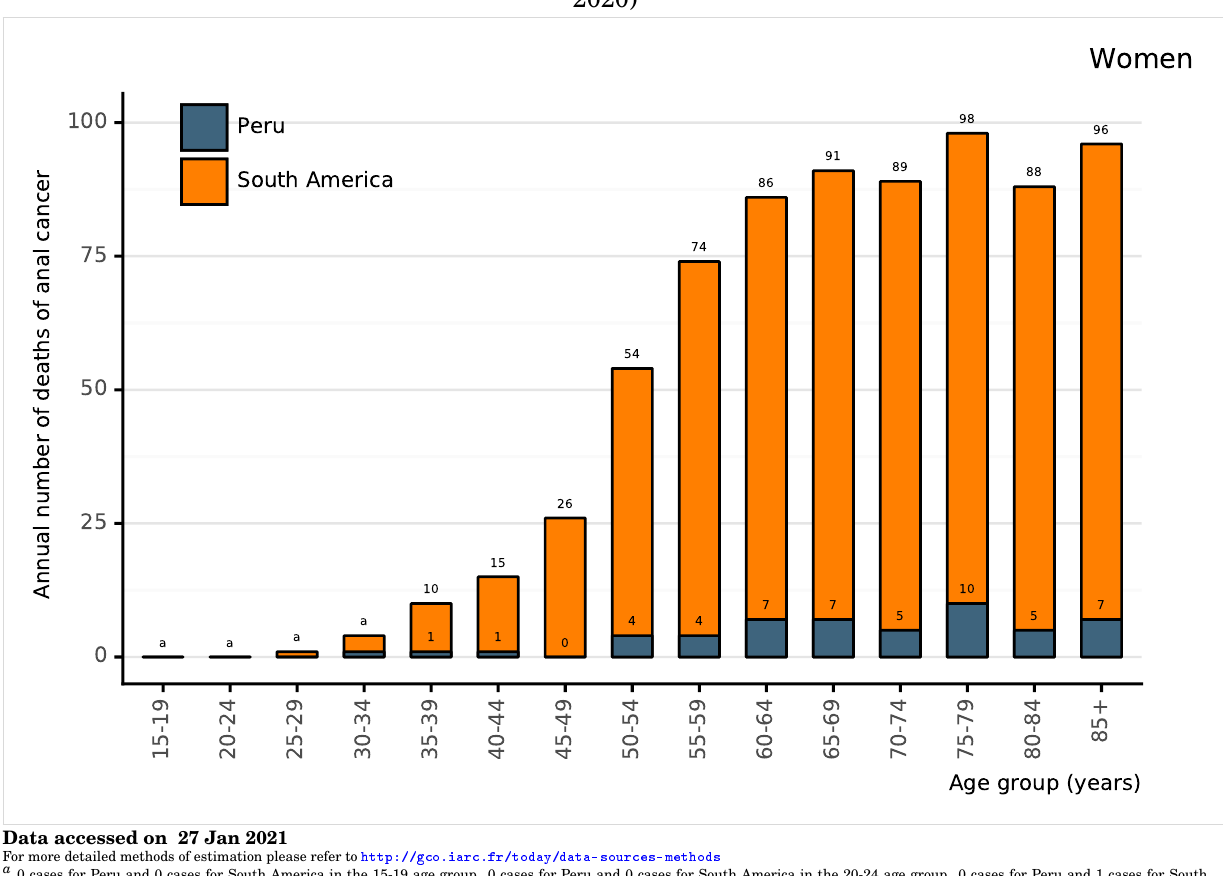
Figure 110: Annual number of deaths of anal cancer among women by age group in Peru (estimates